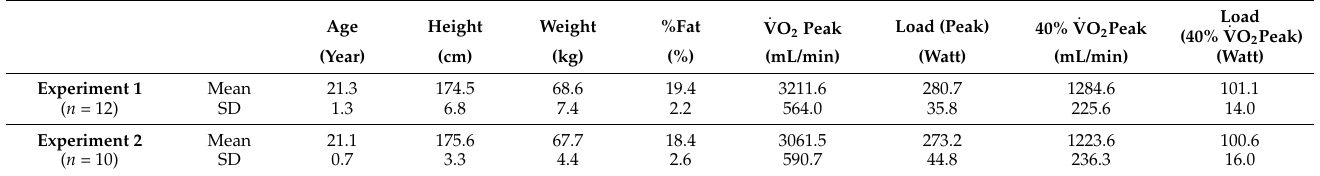
Table 1. Characteristics of participants included in experiments 1 and